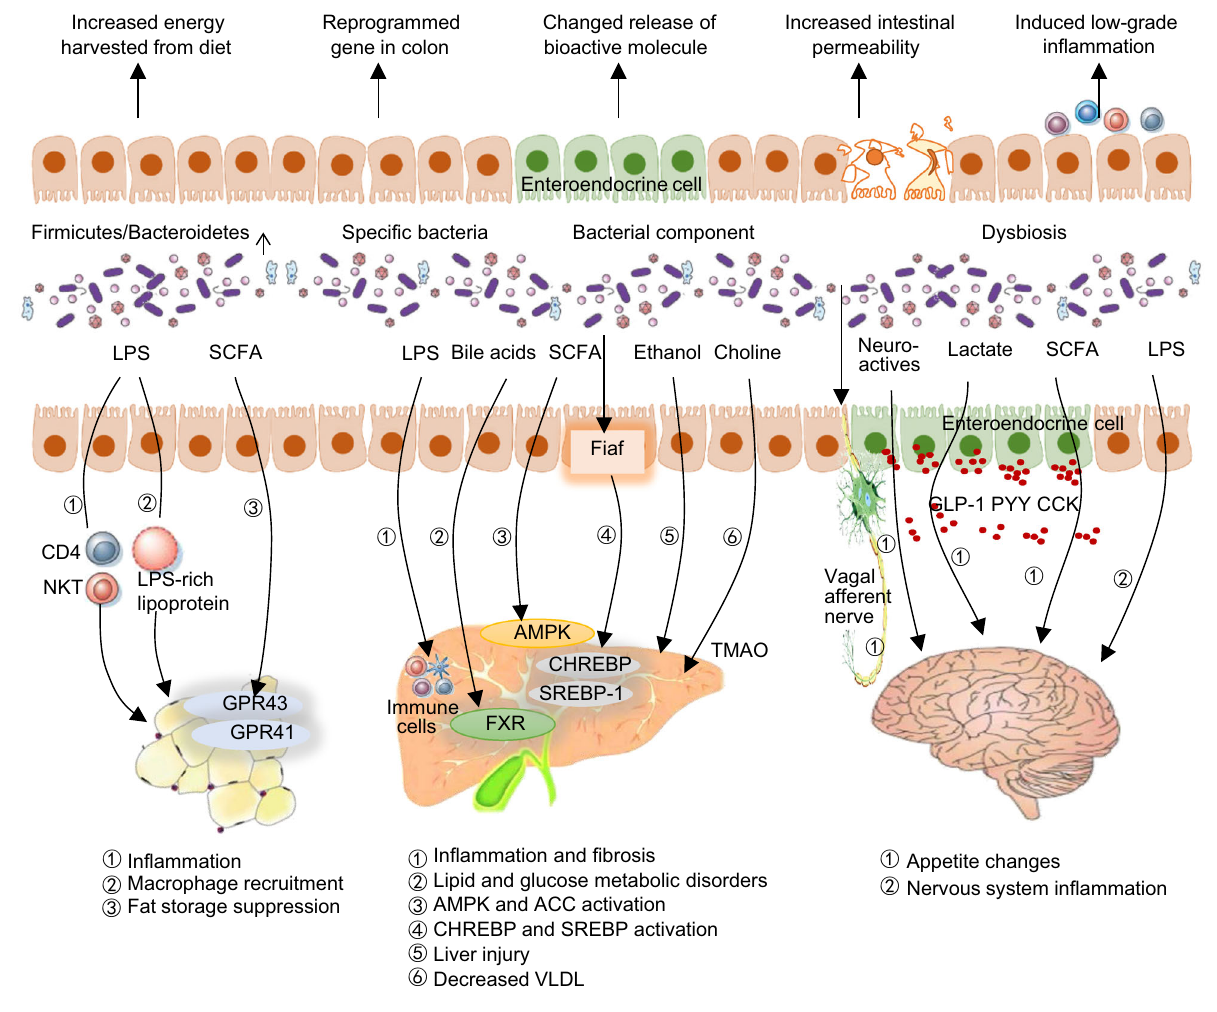
Figure 1. Impact of gut microbiota on local and distant organs contributes to obesity development and progression. In local tissues, obesity-associated gut microbiota have an increased capacity to harvest energy from the diet, stimulate gene reprogramming in the colon, change polypeptide hormones and other bioactive molecules released by EC cells, decrease the intestinal barrier, and disturb immune homeostasis. Gut microbiota also communicate with host adipose tissue and the liver and brain. Microbiota-fat- signaling axis. Gut microbiota participates in the regulation of adipogenesis through distinct mechanisms. LPS triggers an immune response along with in fl ammation and immune-cell in fi ltration. SCFAs also participate in insulin-mediated fat accumulation in adipocytes via activation their receptors GPR43 and GPR41, which inhibits lipolysis and encourages adipocyte differentiation. Gut- liver axis. The presence of a dysbiotic microbiome causes subsequent increases in gut permeability to bacteria-derived pathogens, including LPS and ethanol. In the liver, LPS causes in fl ammation by stimulating immune cells. Certain metabolites, such as bile acids, SCFAs, and TMAO, also play a role in NAFLD pathophysiology. Microbiota-brain-gut axis. Gut afferent neuron and gut hormones are key signaling molecules involved in gut-brain communication and host metabolism. Bioactive molecules involved in this